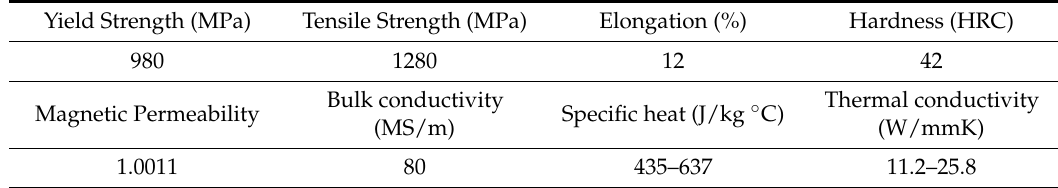
Table 2. The material properties of Inconel 718.